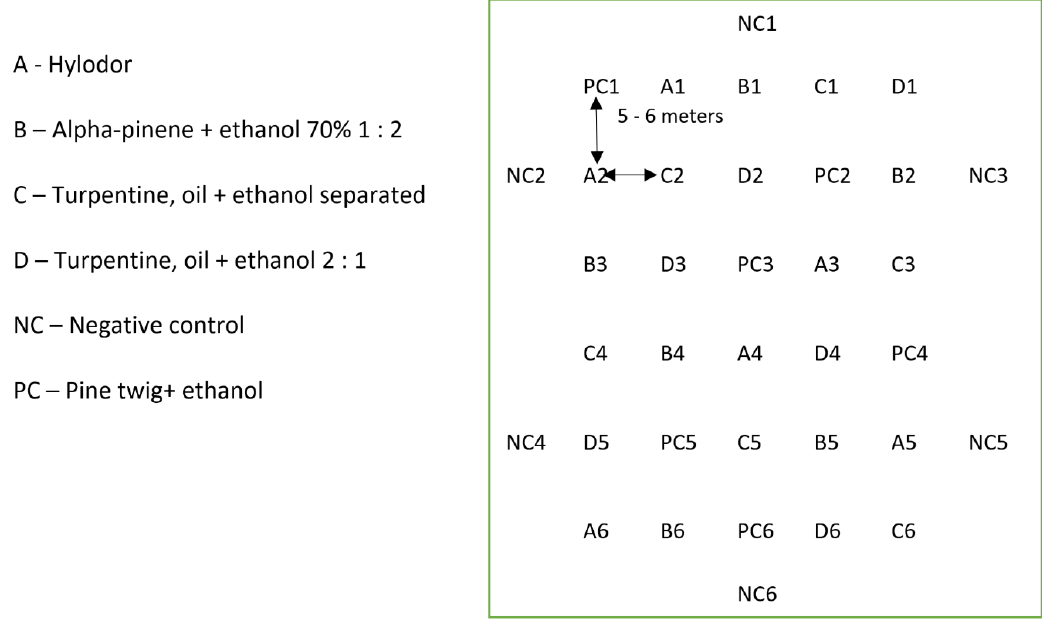
Figure 3. Locations of the pitfall traps in a plot (the attractant is indicated by the letters, and the trap replicate is indicated by the number) .